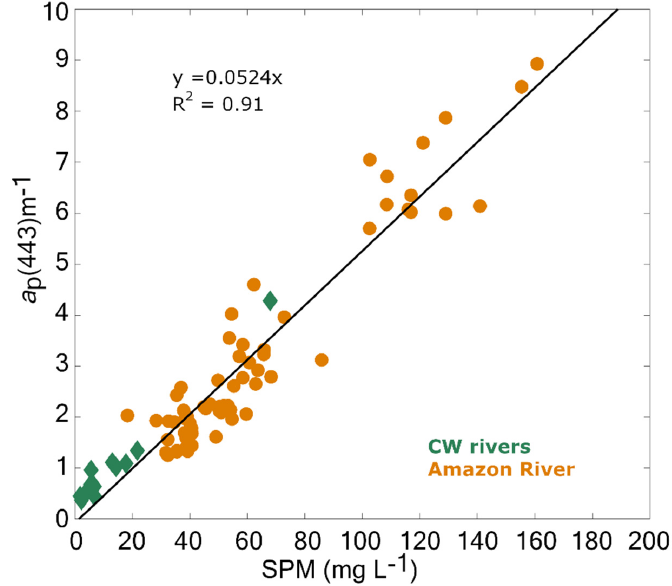
Figure 3. Scatterplot of a p (443) as a function of suspended particulate matter. A linear regression with null intercept is shown by the solid black line.